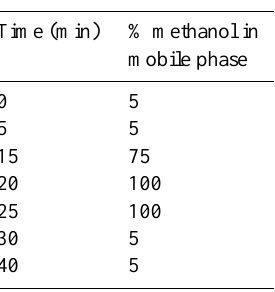
Table 1. HPLC purification profile for sudan-1. Mobile phases were Milli-Q water and HPLC-grade methanol with a system flow rate of 1mLmin − 1 . Fraction collection took place in the range 25.5–